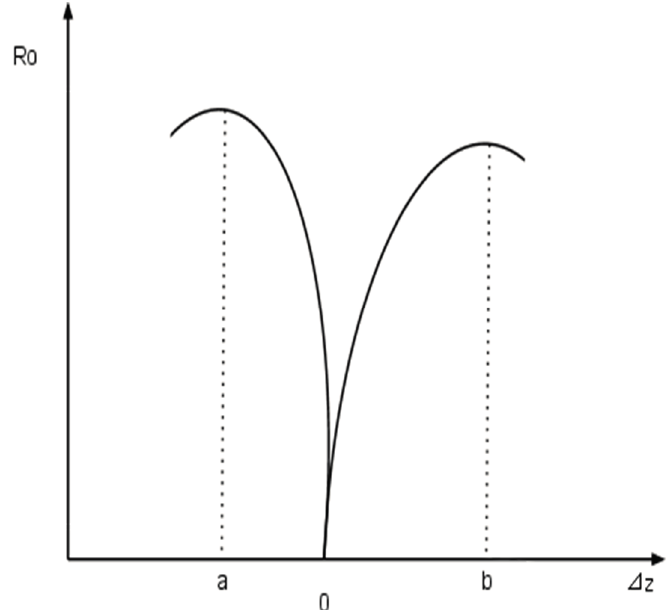
Figure 3. Linear displacement response of cantilevers in broad-band